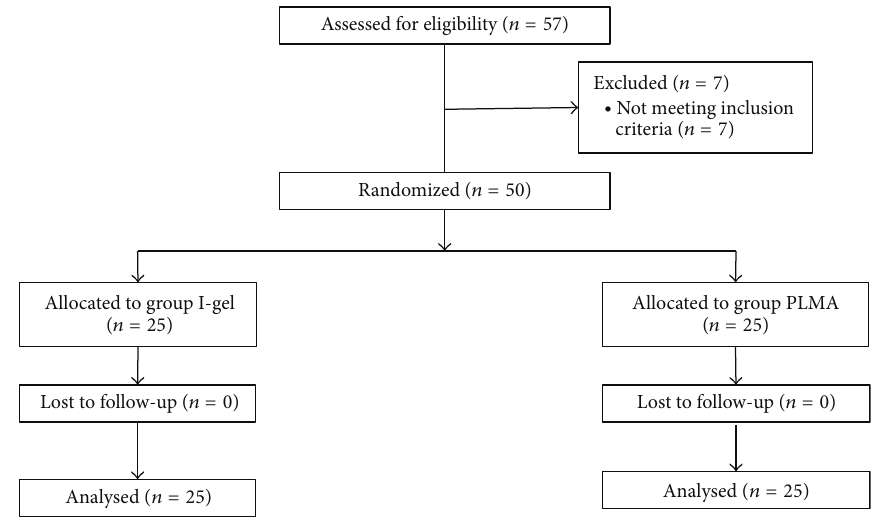
(Table 2). The TV max values were 90 ± 45.91 mL and 69.13 ± 36.79 mL in Group I and in Group P, respectively ( 𝑃 = 0.091 ) (Table 2). The expiratory valves were opened in 6